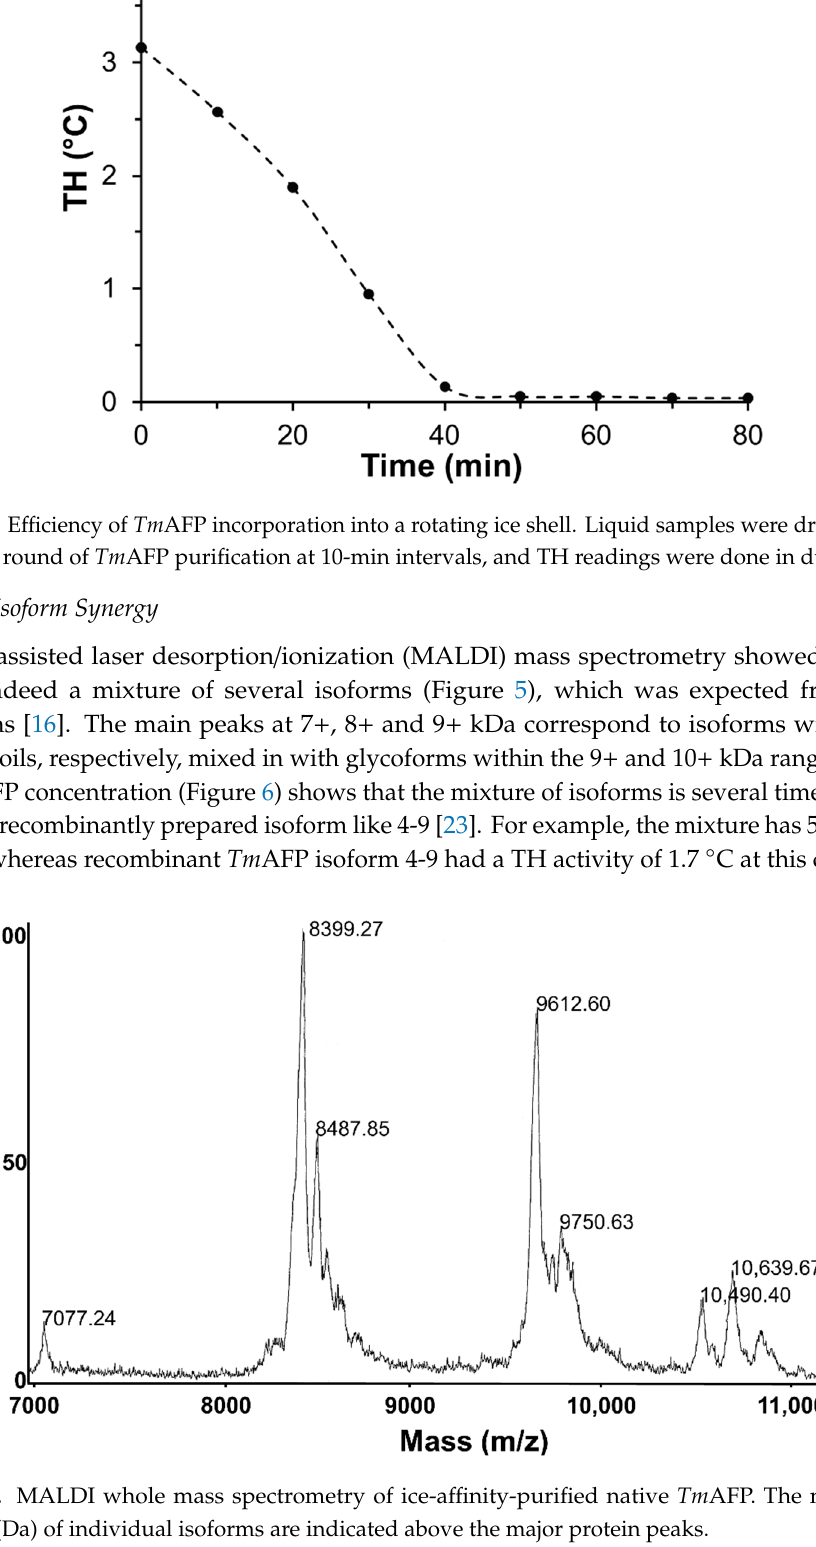
Figure 5. MALDI whole mass spectrometry of ice-affinity-purified native Tm AFP. The molecular weights (Da) of individual isoforms are indicated above the major protein peaks.